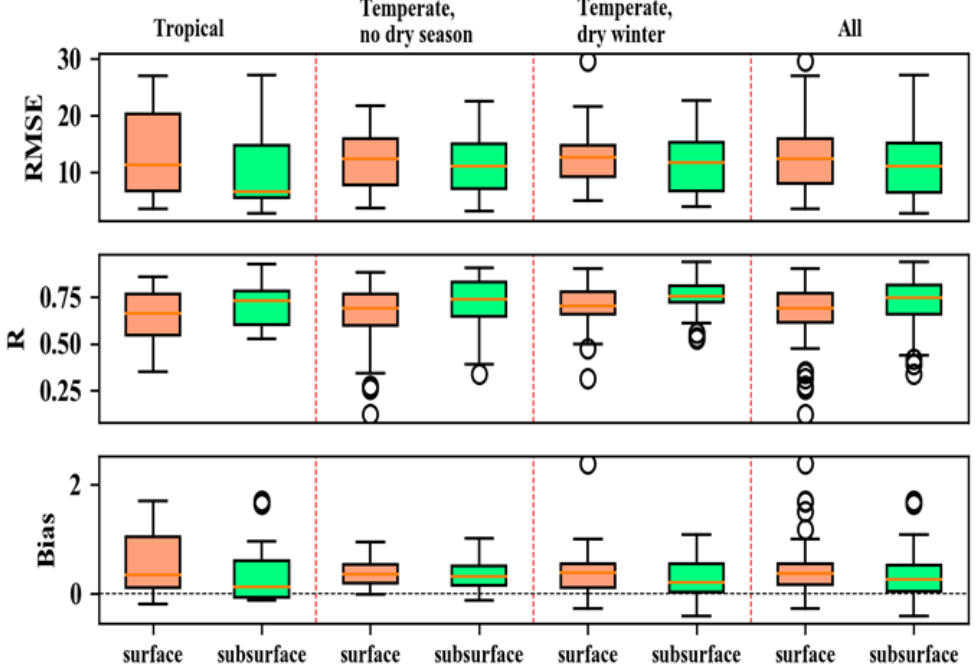
Figure 3. Root mean square error (RMSE), R, and bias of the surface and subsurface soil moisture between the ERA5-Land and in situ data in the three climate zones and the whole study area.